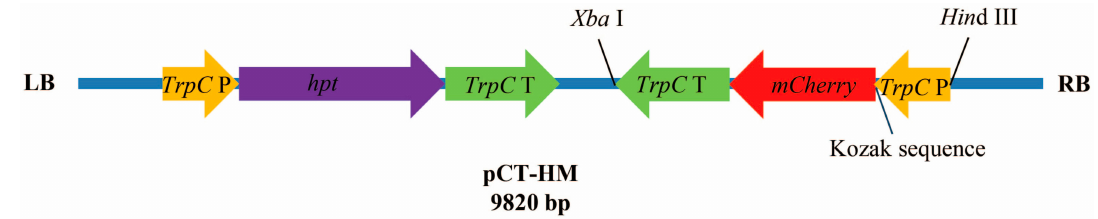
Figure 1. Schematic representation of pCT-HM used for transformation. The mCherry and hpt genes were under the control of the TrpC promoter ( TrpC P) and terminator ( TrpC T). P = promoter; T =